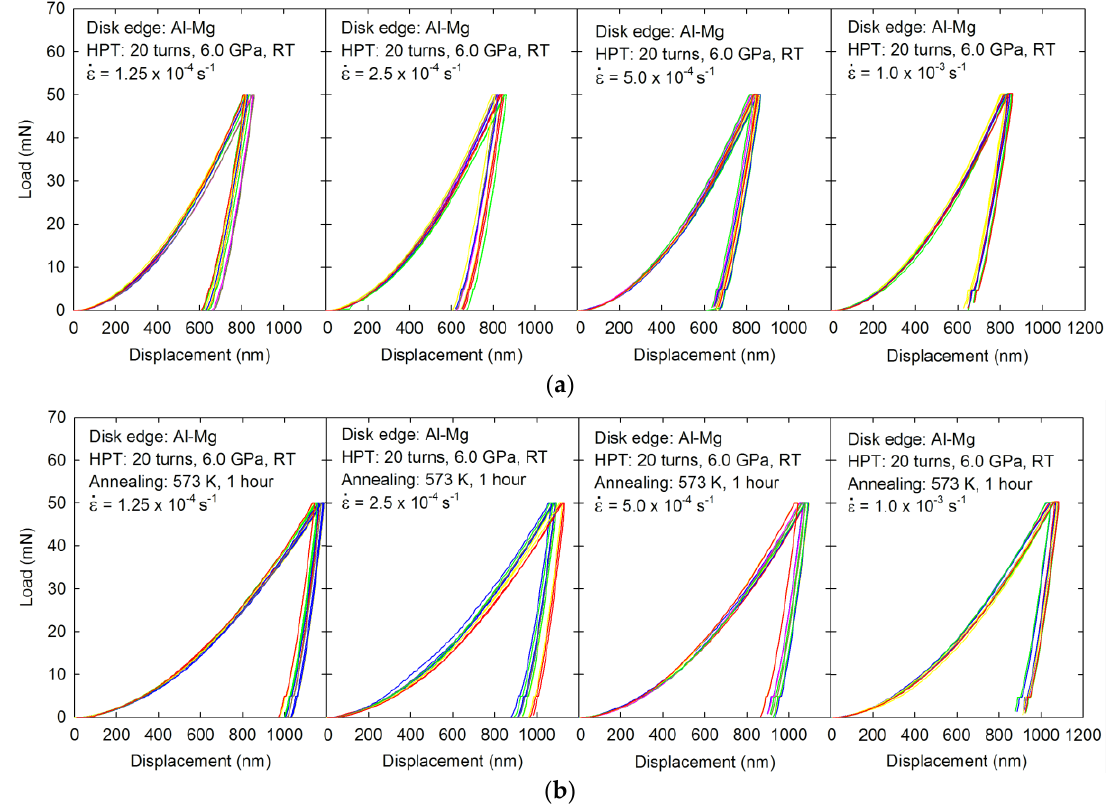
Figure 6. Representative load-displacement curves for the Al-Mg disk edges after ( a ) HPT for 20 turns and ( b ) HPT and PDA when measuring at four strain rates at 1.25 × 10 −4 –1.0 × 10 −3 s −1 .